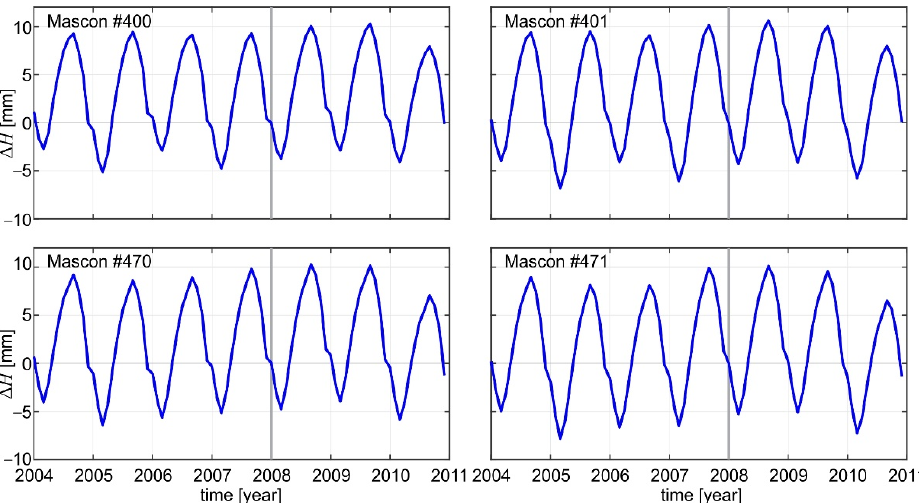
Figure 12. Models of temporal variations of orthometric/normal heights ( ∆ H M / ∆ H * M ) referred to the reference epoch t 0 , i.e., 01.01.2008.